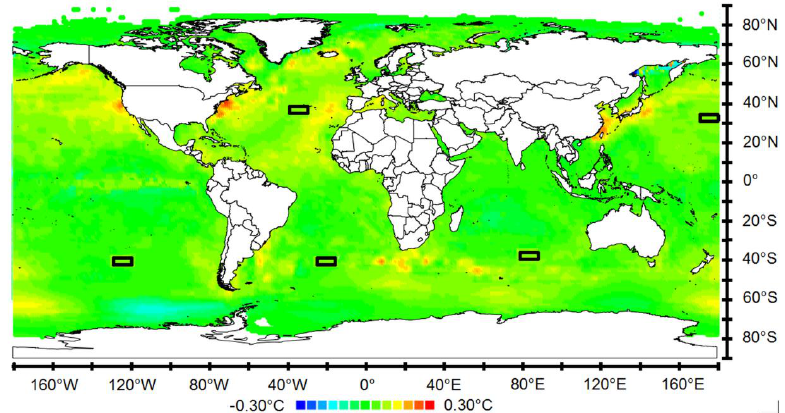
Figure 2. Wavelet power of SST in 1958, scale-averaged over the 48 – 96-year band (64-year average period). Areas from which SST anomalies are averaged are displayed. Data are provided by the “Met Office Hadley Centre ” [ 21].